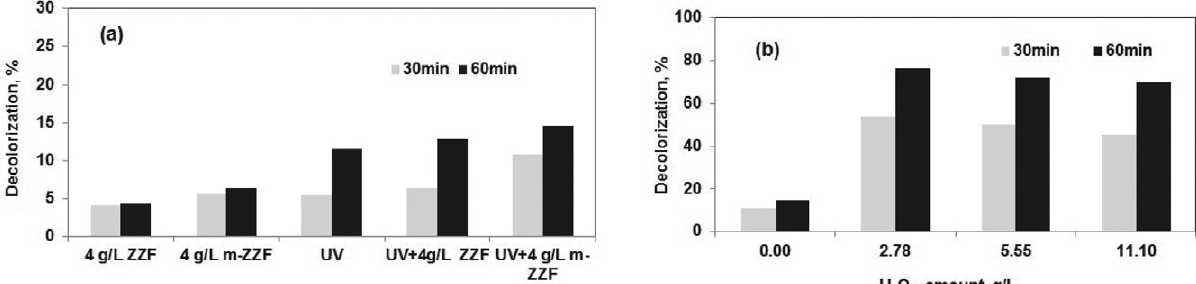
Fig. 4. Effect of (a) HCl modification of catalyst (initial dye concentration: 0.04 g/L, initial temperature: 25 °C, catalyst amount: 4 g/L, original pH) and (b) H 2 O 2 concentration (initial dye concentration: 0.04 g/L, initial temperature: 25 °C, m-ZZF amount: 4 g/L, original pH, UV light) on the decolorization of